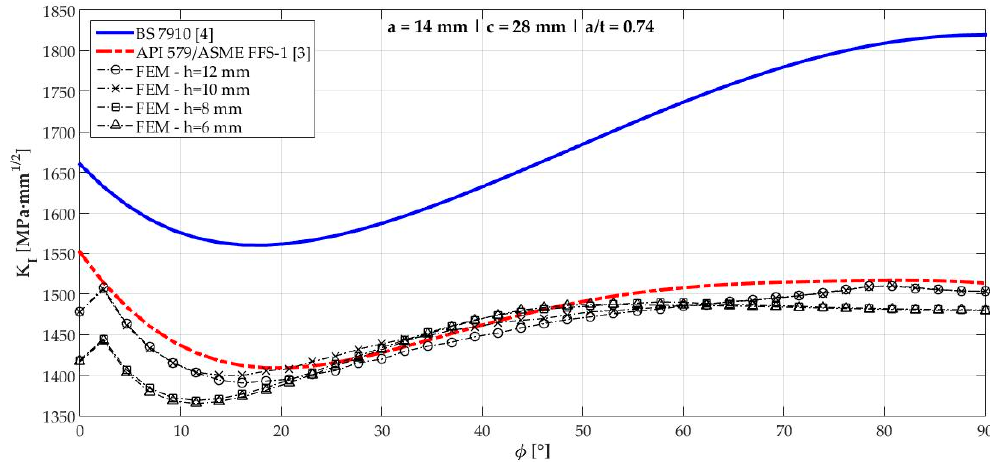
Figure 9. Mode I SIF profiles for crack 4 ( a = 14 mm , c = 28 mm , and a/t = 0.74 ).